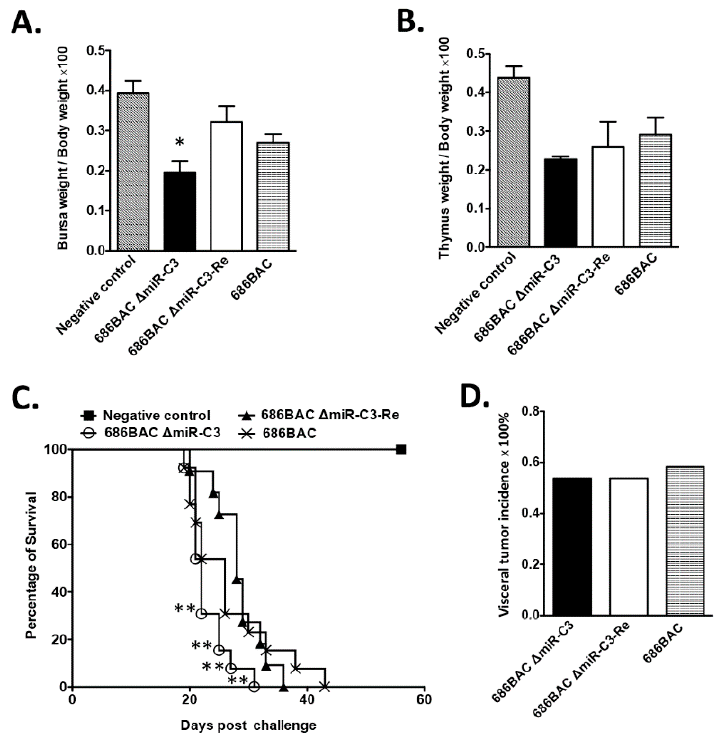
Figure 3. Evaluation of mutant 686BAC ∆ miR-C3, revertant 686BAC ∆ miR-C3-Re, or parental 686BAC pathogenesis in chickens. One-day-old, specific pathogen-free chickens were inoculated with 2000 plaque-forming units (PFUs) of parental 686BAC, mutant 686BAC ∆ miR-C3, or revertant 686BAC ∆ miR-C3-Re. One group of chickens remained inoculated and served as a negative control. ( A , B ) Lymphoid organ atrophy. At 14 days post-inoculation (dpi), body and lymphoid organs (bursa and thymus) weights of the negative control and inoculated chickens were measured. Results are presented as the average ratios of (bursa to body weight) × 100 ( A ) and (thymus to body weight) × 100 ( B ), with the error bar representing the standard error of the mean (SEM). ( C , D ) Pathogenesis of recombinant viruses. Inoculated and negative control chickens were maintained for 8 weeks. The mortality rate (presented as percentage of survival at each dpi) of each group is plotted, and the trends